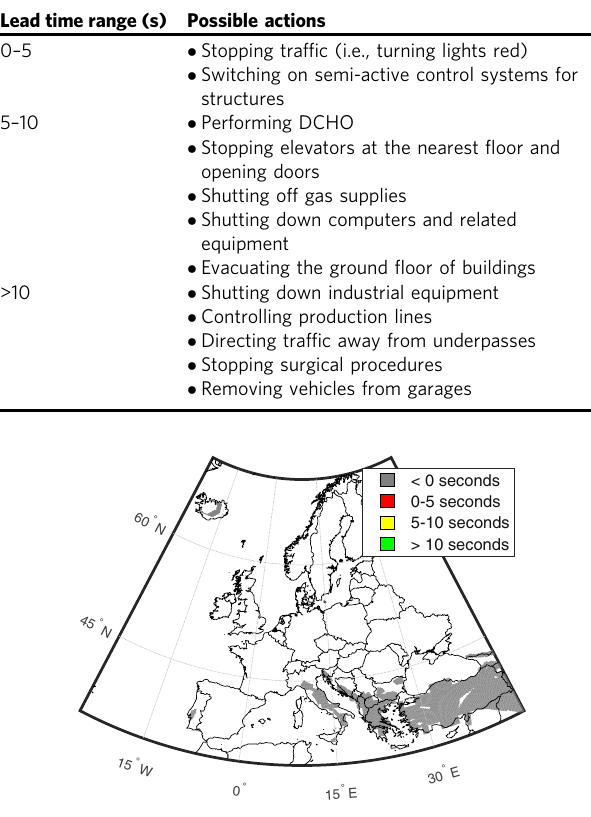
Fig. 5 Lead-time mapping for M w 5 events.